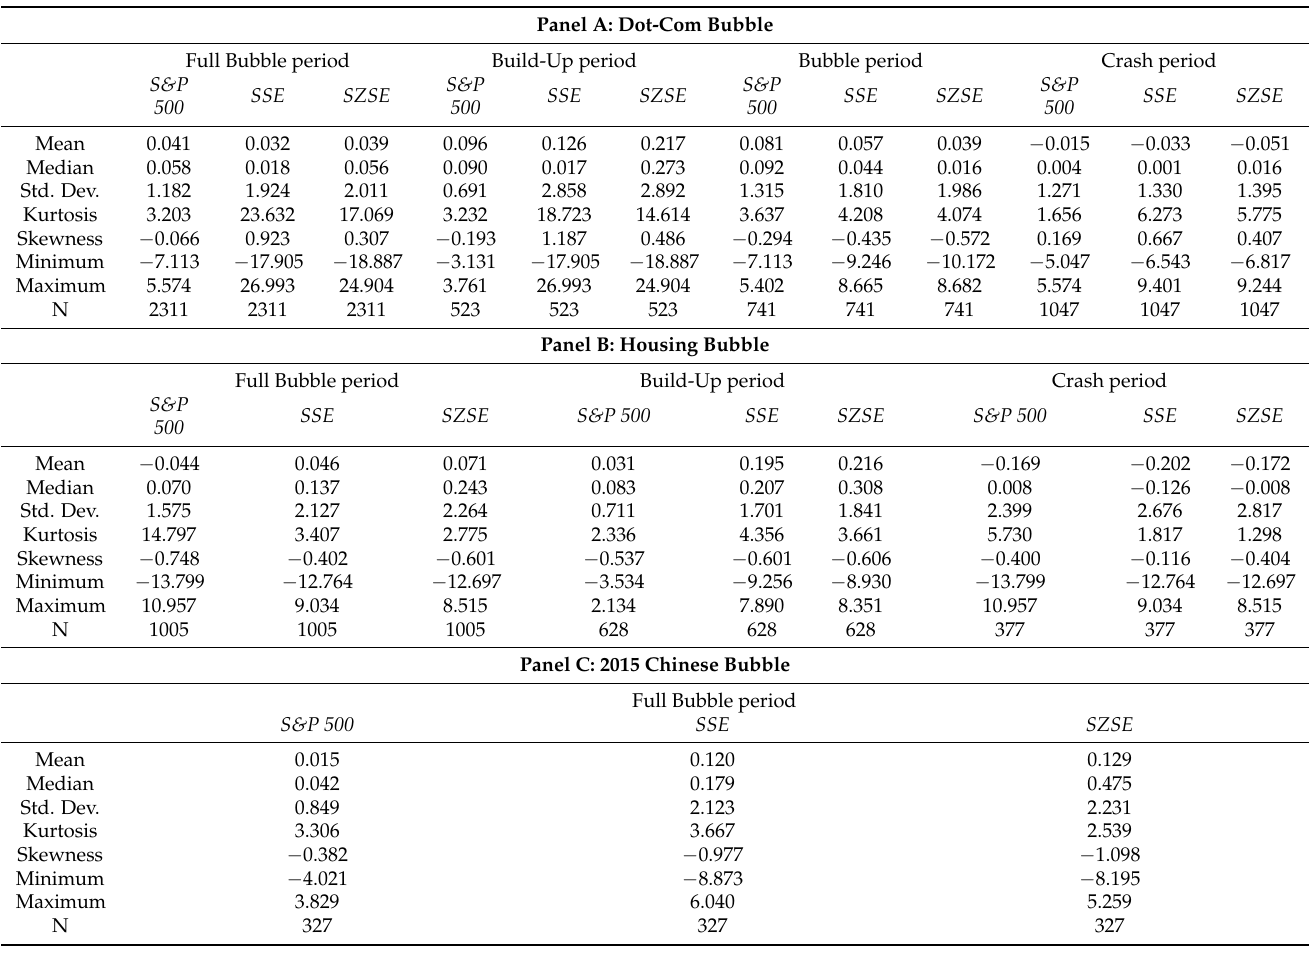
Table 1. Descriptive Statistics of Returns